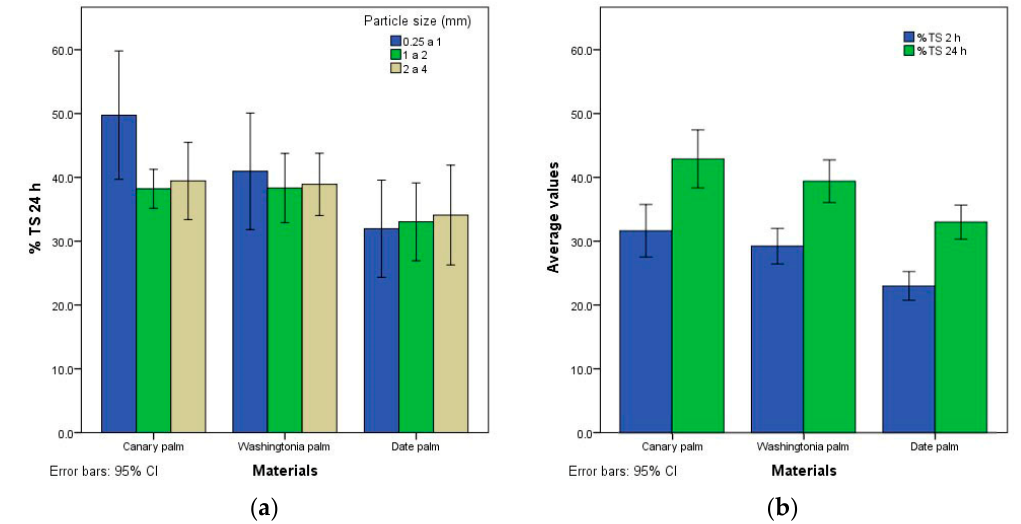
Figure 4. ( a ) Average TS values after 24 h of water immersion according to the palm species and particle size ( b ) Average TS values after 2 and 24 h according to palm species.